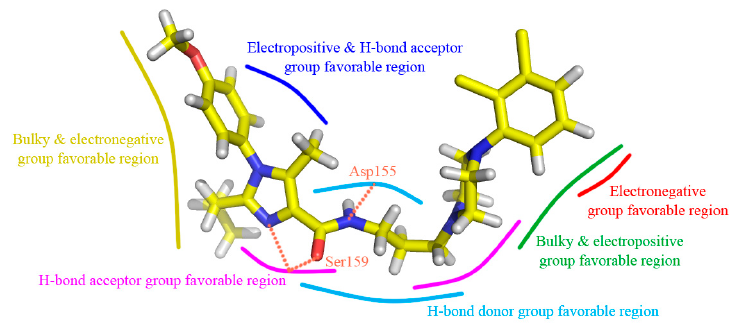
Figure 13. Crucial interaction features of template compound 13 with 5-HT 2A receptor.